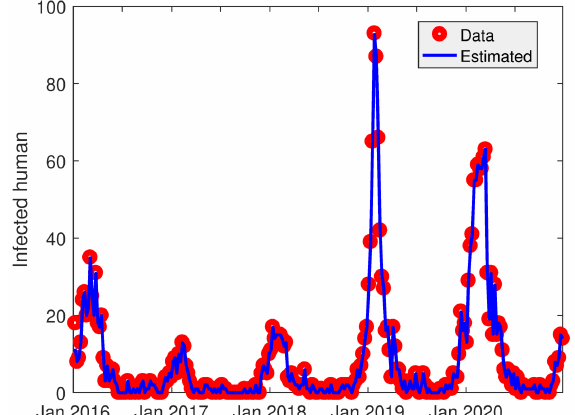
Figure 2. Plot of data vs. estimation.